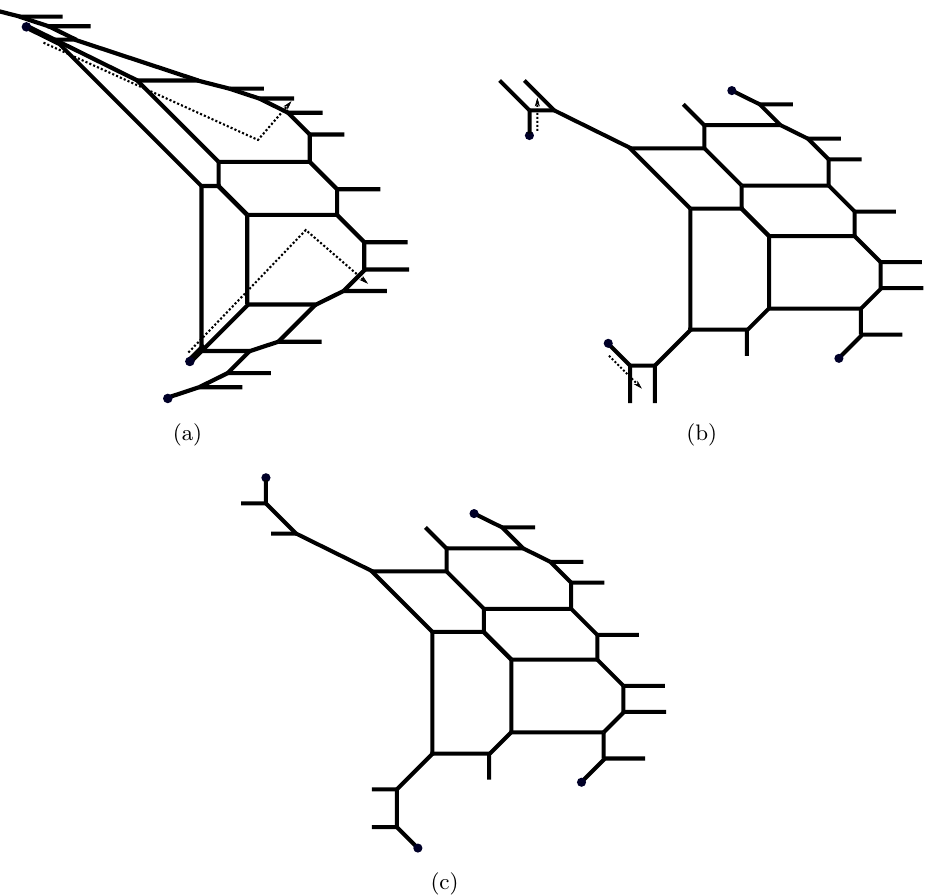
; N F = 13 ; (cid:20) = 2